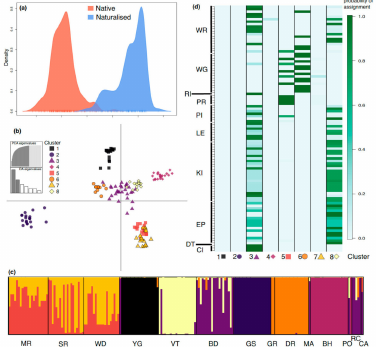
Figure 3. Discriminant analysis of principal components (DAPC) reveals genetic structuring at the regional and native population levels, while also revealing sources of genetic material for the naturalized populations. ( a ) Di ff erences in the structure and amount of genetic variation between native and naturalized populations. ( b ) Genetic di ff erences between native populations explaining 58.2% of the variation ( x -axis: 37.2%; y -axis: 21.0%). ( c ) For the native populations, individual probabilities of the eight genetic clusters, where each bar represents an individual and the y -axis is the probability, with 0 at the bottom and 1 at the top. ( d ) Probabilities of assignment of naturalized individuals to native genetic clusters, with naturalized populations on the y -axis and genetic clusters on the x -axis. Genetic cluster colors for a, b, and c indicate the same clusters, and shapes for b and c are the